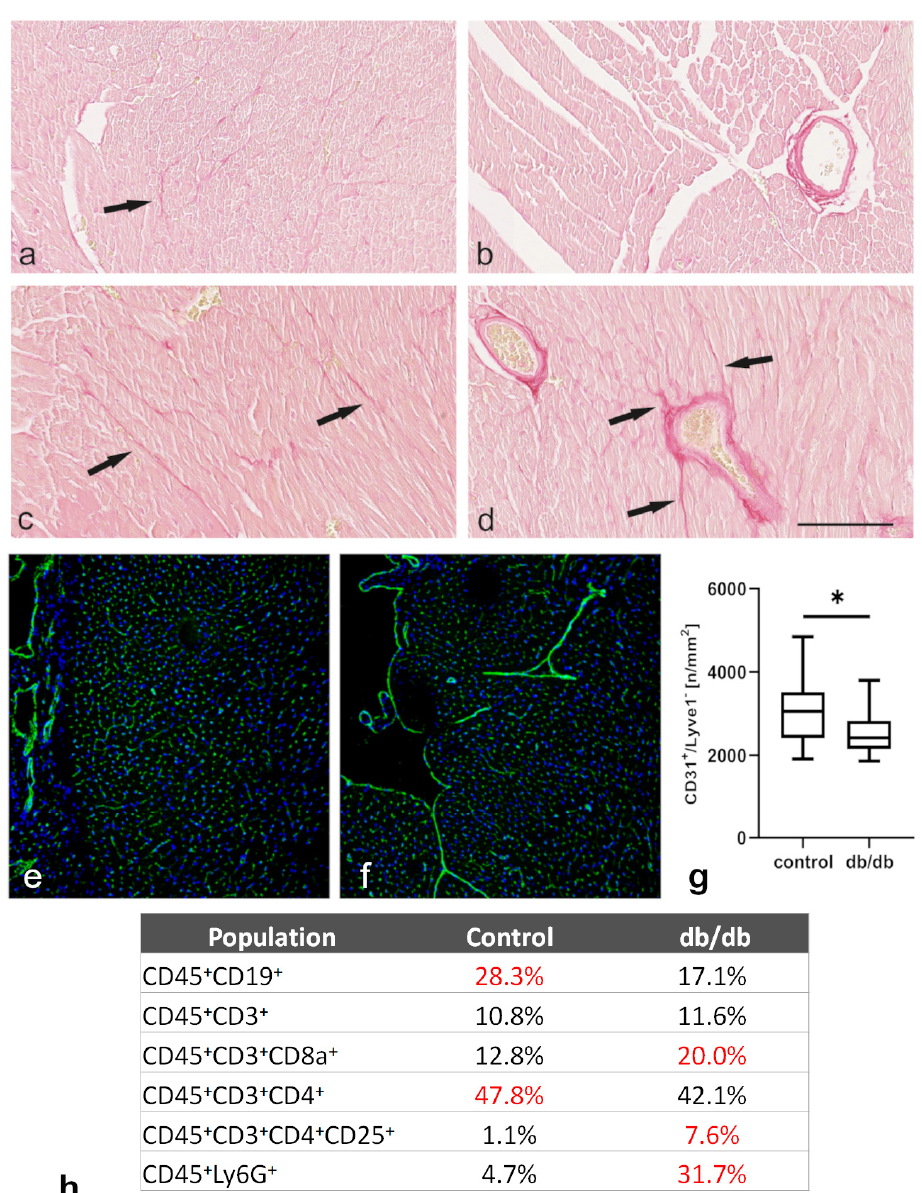
towards interstitial cardiomyocytes positioned adjacent to coronary vessels (black arrows in d).